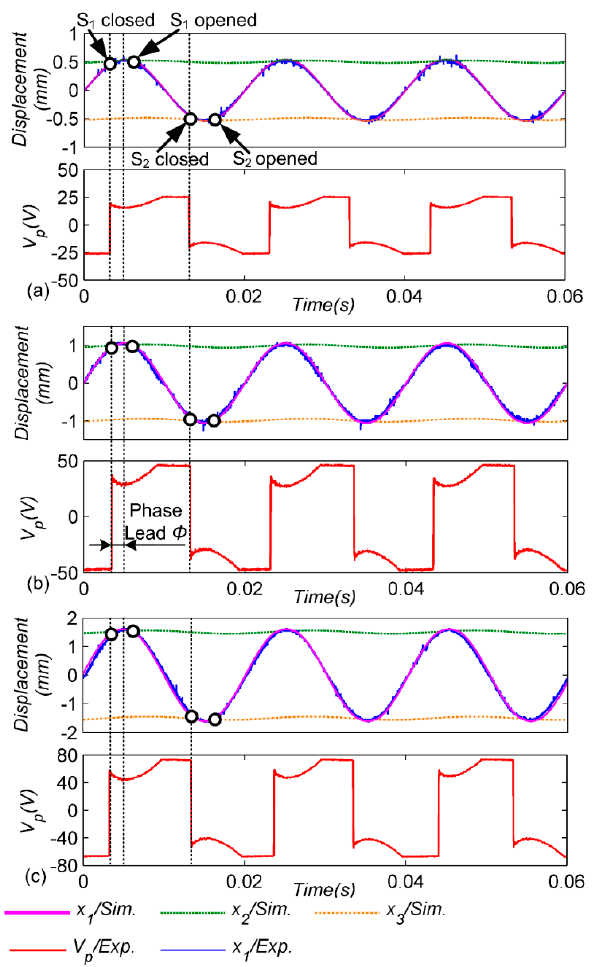
Figure 6. Experimental and simulated waveforms for different vibration amplitudes at a constant frequency f = 50 Hz: ( a ) A m = 0.5 mm; ( b ) A m = 1 mm; ( c ) A m = 1.5 mm.